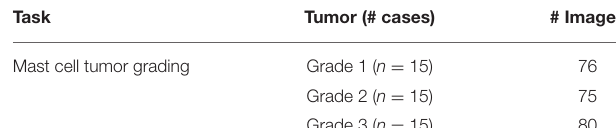
TABLE 2 | Mast cell tumors grading according to Patnaik.